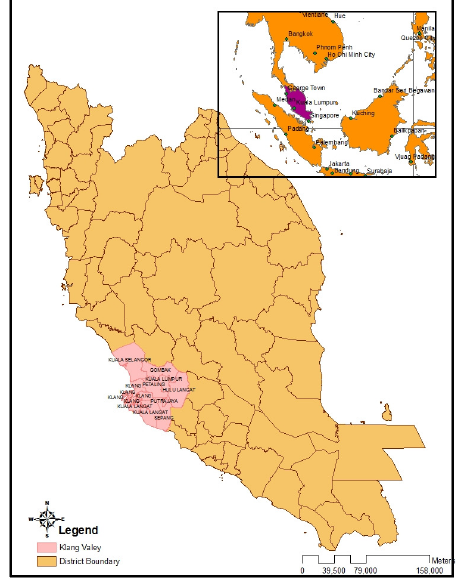
Figure 1 . The Peninsular